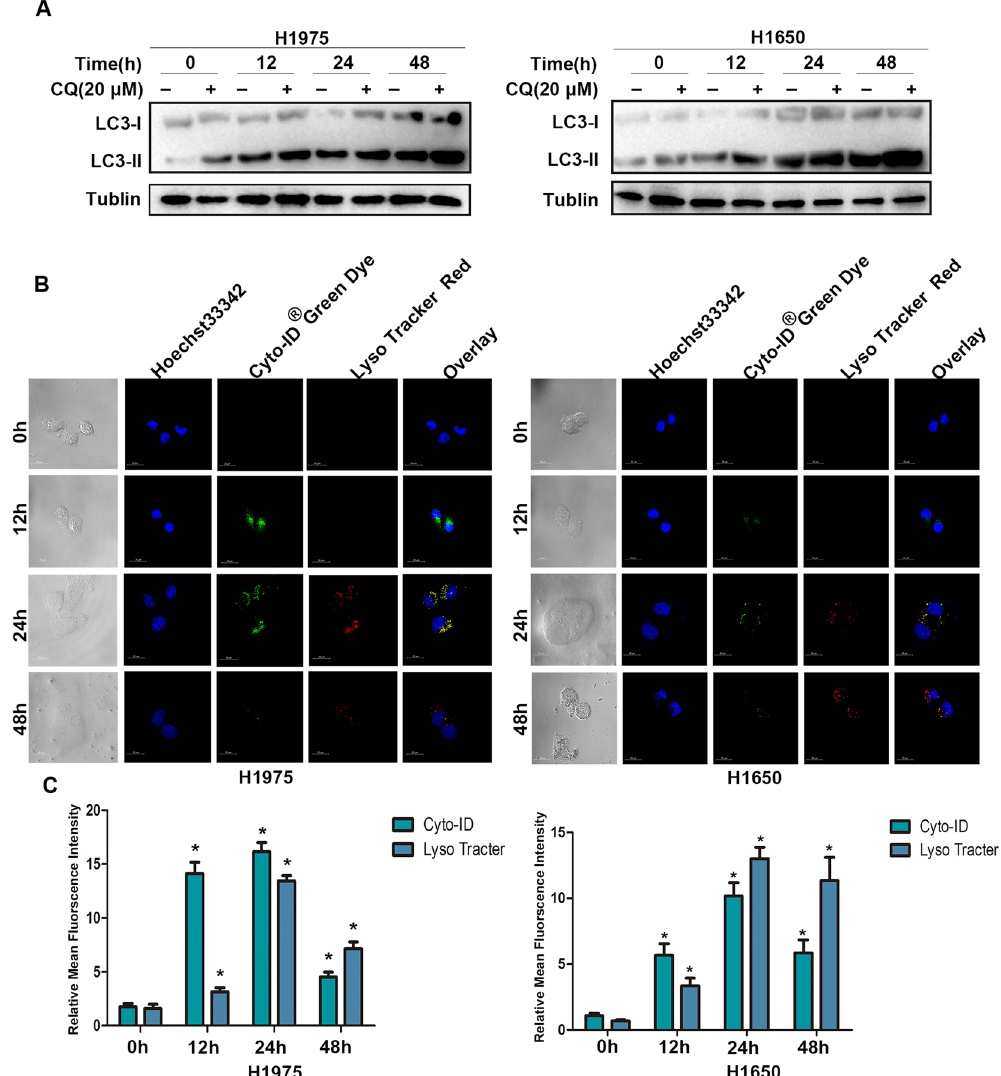
Figure 4. Afatinib triggers autophagic flux in H1975 and H1650 cells. ( A ) H1975 and H1650 cells were simulated by 10 μ M afatinib in the presence or absence of 20 μ M CQ for 0, 12, 24 and 48 h. The production of LC3-I/II were measured by western blot analysis. These blots were cropped with Photoshop CS6. ( B ) H1975 and H1650 cells were treated with 10 μ M of afatinib for 0, 12, 24 and 48 h and the autophagic fluxes were detected with confocal fluorescent microscopy ( C ) The ImageJ was used to perform the quantitation analysis in the Fig. 4B. These data were presented as mean ± SD ( * P < 0.05 versus